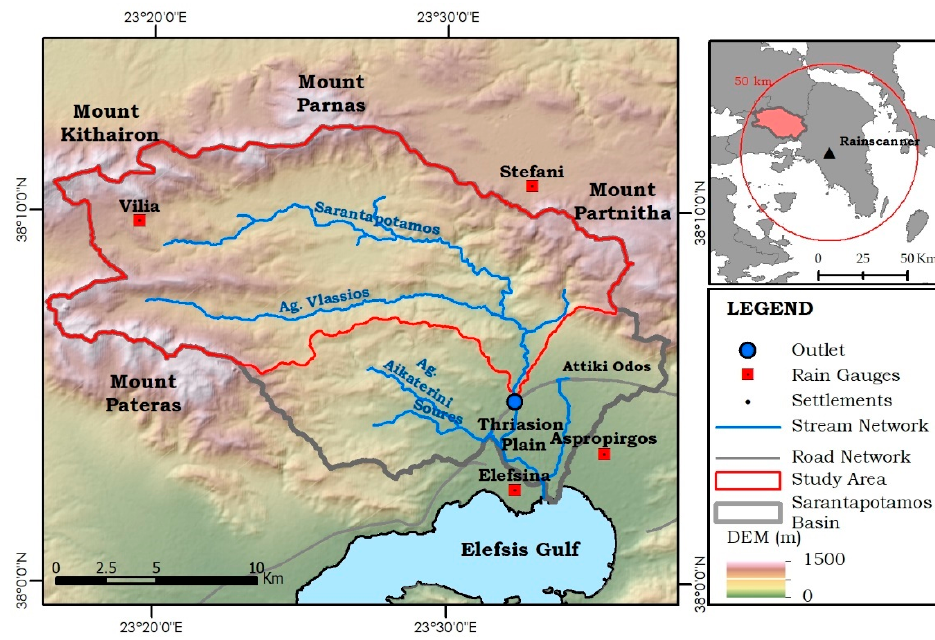
Figure 1. The Sarantapotamos basin, the study area and the rain gauge